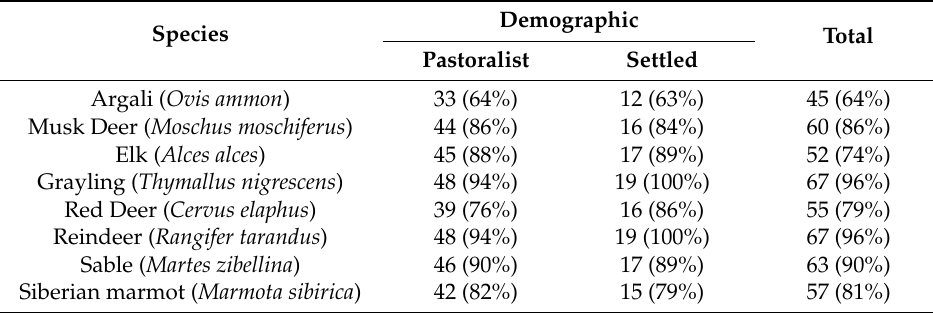
Table 2. Levels of awareness for key and vulnerable species at